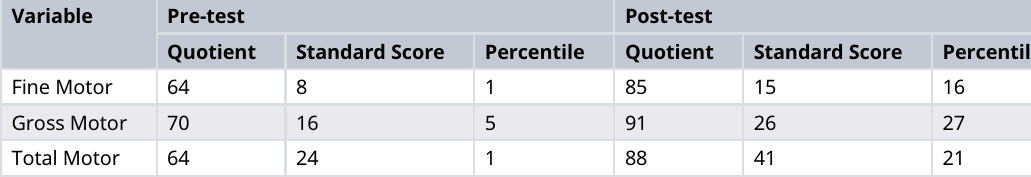
Table 1. Pre- and post-intervention Peabody Developmental Motor Scale-2 (PDMS-2)